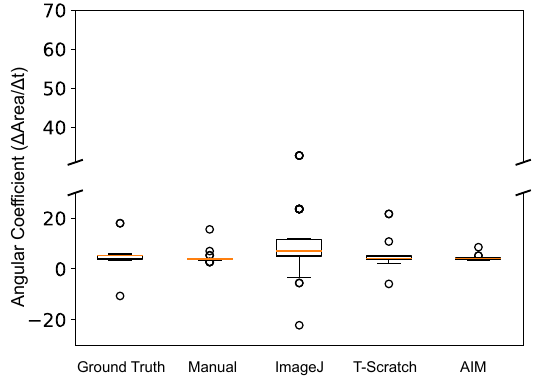
Figure 5. Distribution of the differential invasiveness of TGF- β 1-treated cells and the control population computed using each one of the 57 different combinations of the acquired time points using all the considered methods. Among them, AIM is the one associated with the lowest variability of this